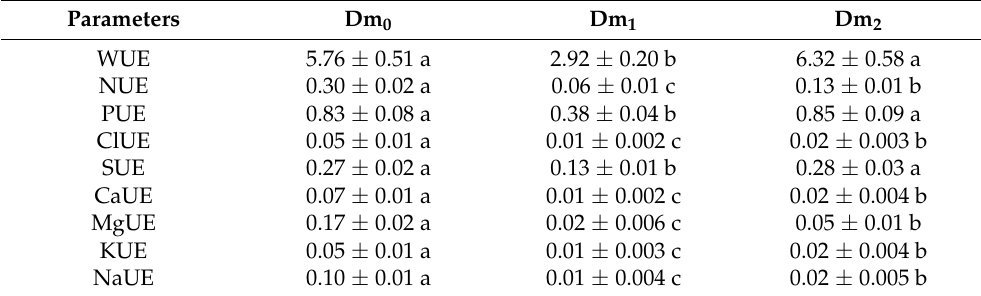
Table 7. The effects of different fertigation treatments (Dm 0 —standard nutrient solution, Dm 1 —raw leachate treatment, and Dm 2 —raw leachate blended with H 2 O 2 treatment) on water and nutrient use efficiencies in D. marginata plants at the end of the experiment. The results are expressed as means ± standard deviation ( n = 4). In each column, the same letters indicate non-significant differences ( p <